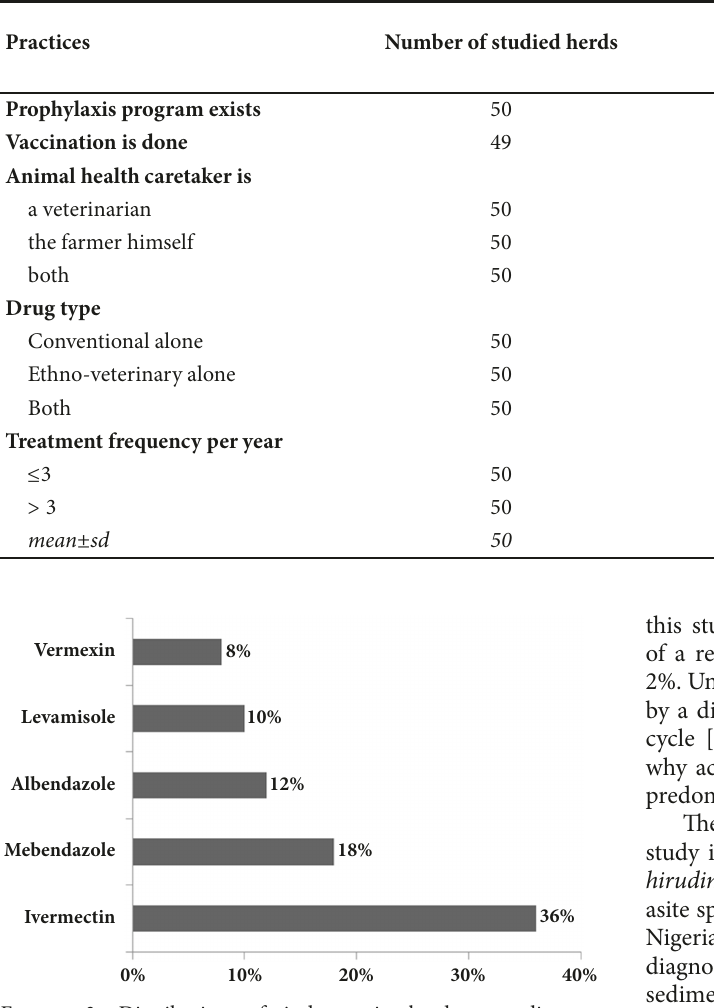
Figure 3: Distribution of indoor pig herds according to anthelmintic usage in Bamboutos,